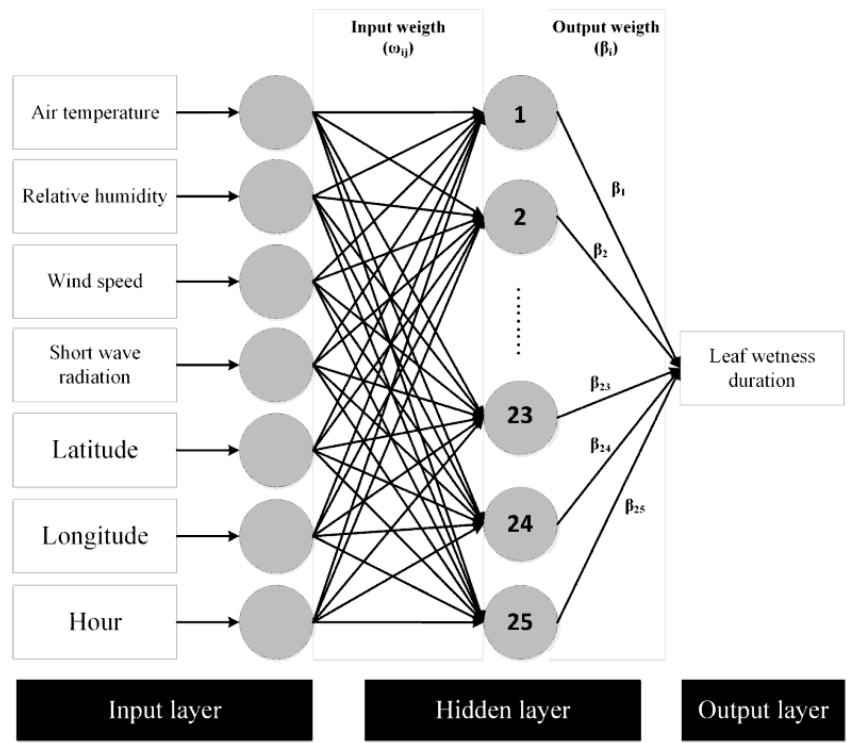
Figure 3. Structure of the extreme learning machine (ELM) model used in this study.